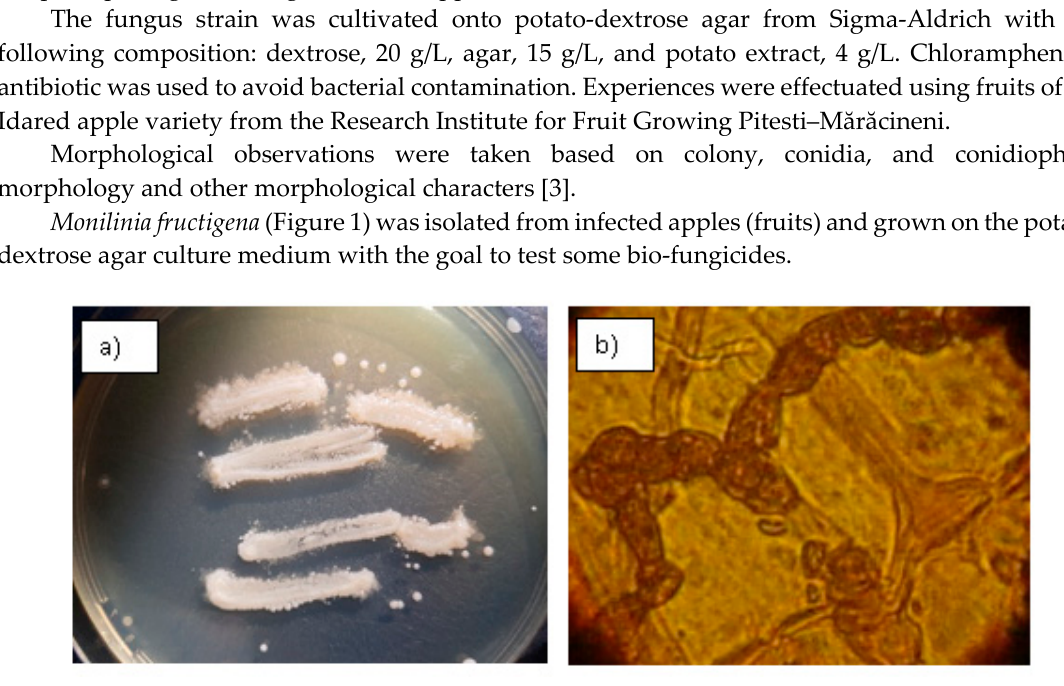
Figure 1. Monilinia fructigena ( a ); microscope view of Monilinia fructigena ( b